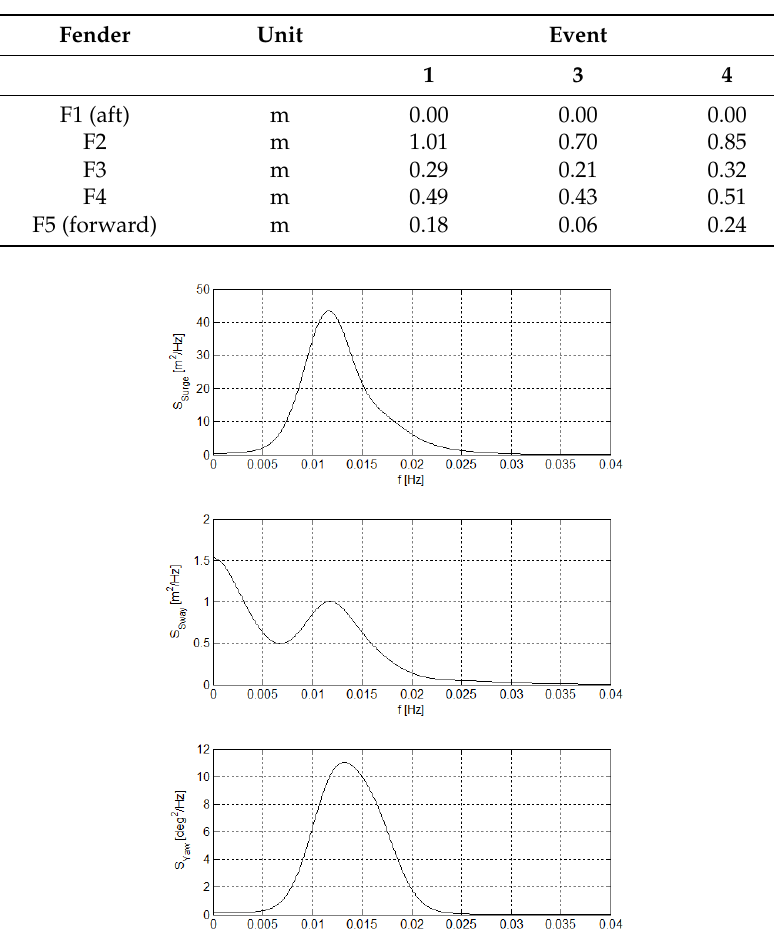
Table 6. Maximum fender compressions for the Base Case.